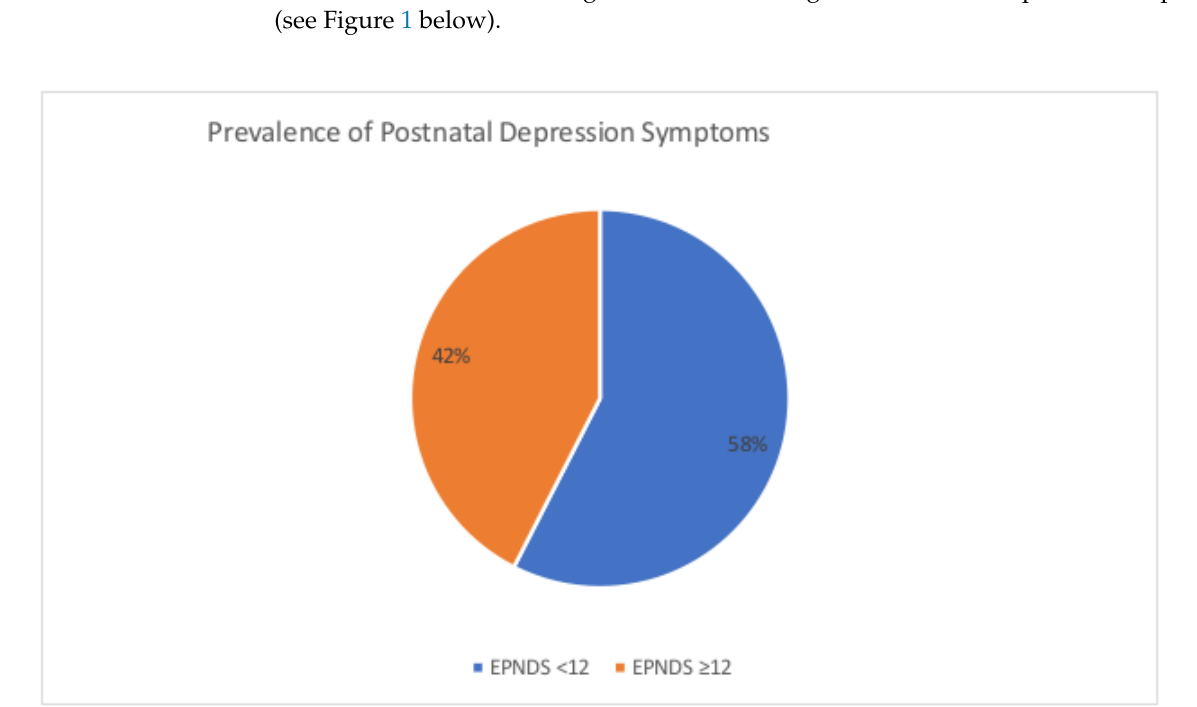
Figure 1. Prevalence of postnatal depression (PND) symptoms.